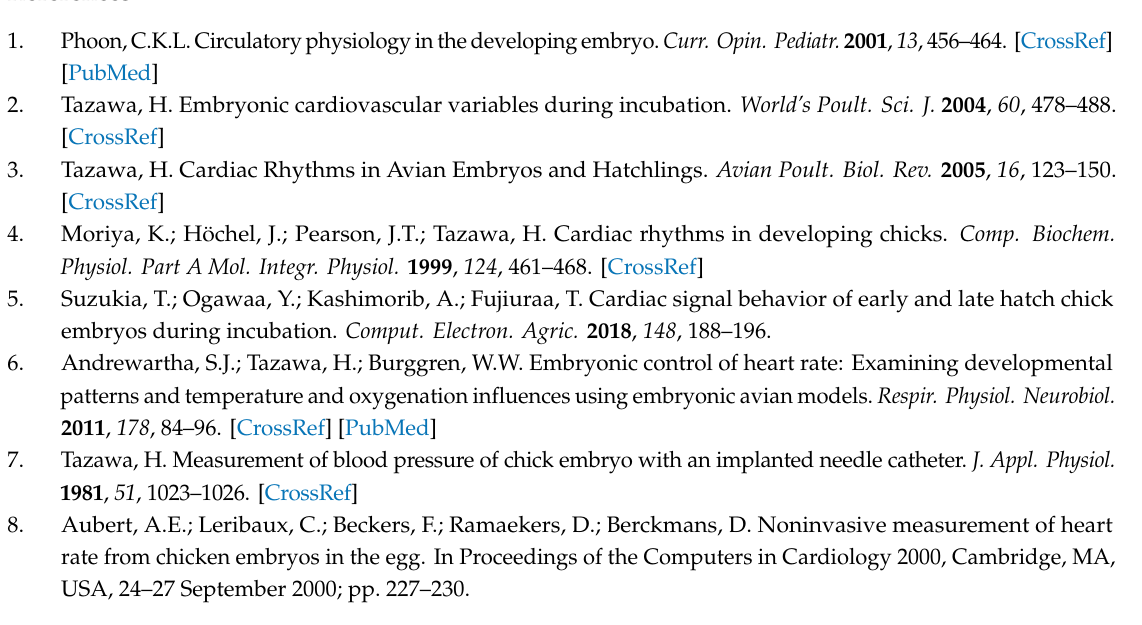
Figure S1. PPG waveforms and power spectrum obtained for an infertile egg on day 9 (sample no. 21) (Table S1) using the smartphone HR device. (a) Raw PPG waveform. (b) PPG waveform after detrending and filtering. (c) Power spectra of (a) showing no cardiac signal in the range 2–5 Hz. (d) Picture of a broken egg on day 21 showing that the egg was infertile. Figure S2. Power spectra for all 6 dead eggs (No. 5, 10, 17, 25, 47, 53) (Table S1) obtained on the day before and the day each embryo died, during incubation. Pictures of the eggs broken on day 21 were used to confirm that the eggs were fertile, but the embryos died during incubation. Table S1. Measured heart rates using the proposed smartphone setup for 60 chicken eggs during days 1–20 of